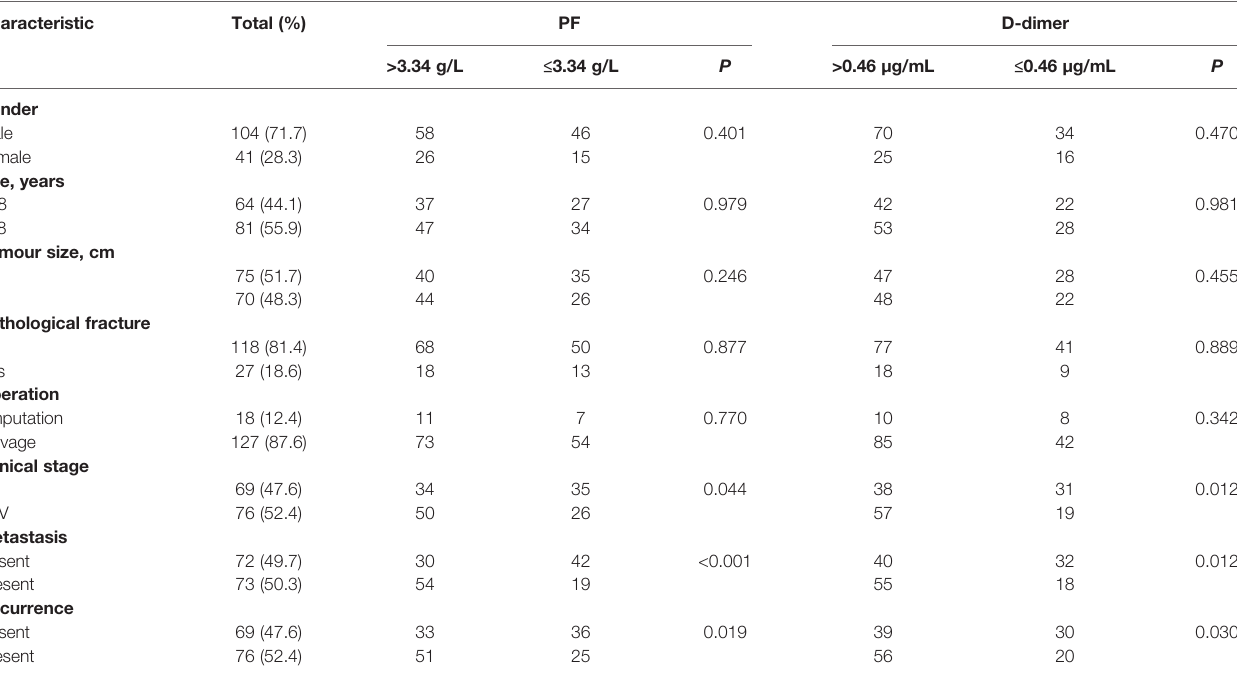
TABLE 1 | Associations of PF and D-dimer with clinicopathological factors of 145 patients with osteosarcoma.